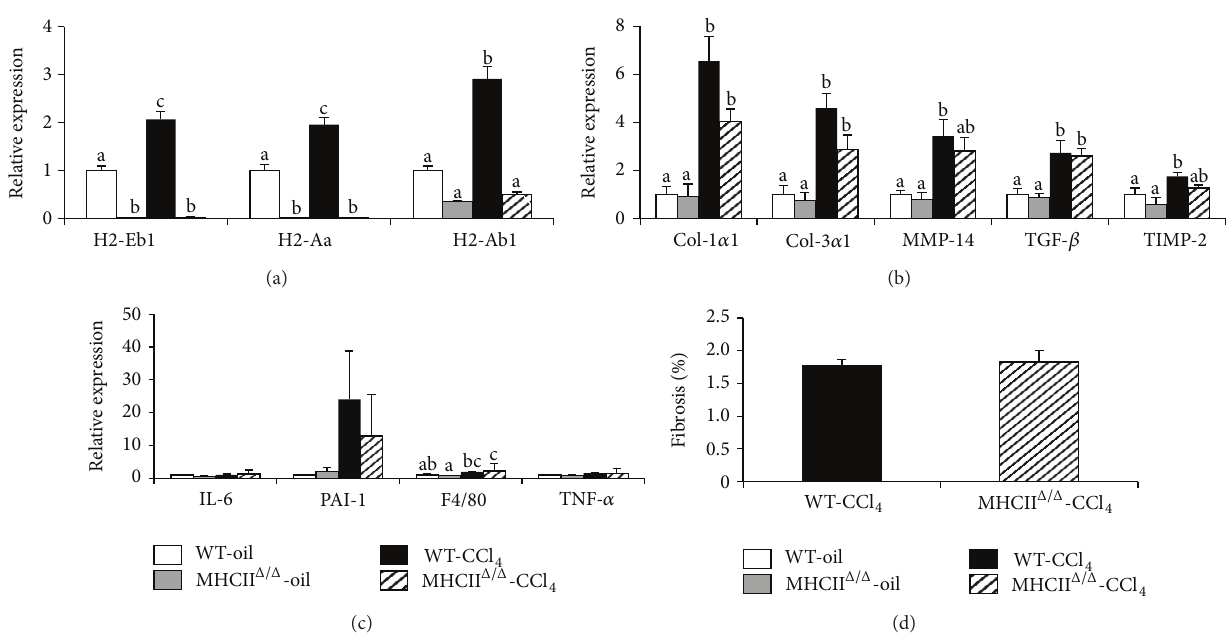
Figure 6: Effect of 4-week CCl 4 treatment on hepatic gene expression and fibrosis in wild-type and MHCII Δ/Δ mice. Open bars represent oil- treated wild-type (WT-oil, 𝑛 = 7 ), closed bars CCl 4 -treated wild-type (WT-CCl 4 , 𝑛 = 11 ), gray bars oil-treated MHCII Δ/Δ mice (MHCII Δ/Δ - oil, 𝑛 = 5 ), semiclosed bars CCl 4 -treated MHCII Δ/Δ mice (MHCII Δ/Δ -CCl 4 , 𝑛 = 9 ). Data are presented as mean ± SEM. (a) MHC II gene expression. (b) Gene expression related to fibrosis formation. (c) Gene expression related to inflammation. (d) No difference in fibrosis (%) between groups treated by CCl 4 . The percentage was determined based on the sirius red staining (5 pictures/mice, WT-CCl 4 : 𝑛 = 5 , MHCII Δ/Δ -CCl 4 : 𝑛 = 8 ). a , b , c 𝑃 < 0.05 , ANOVA and Tukey Kramer HSD test. Different letters indicate the significant difference between